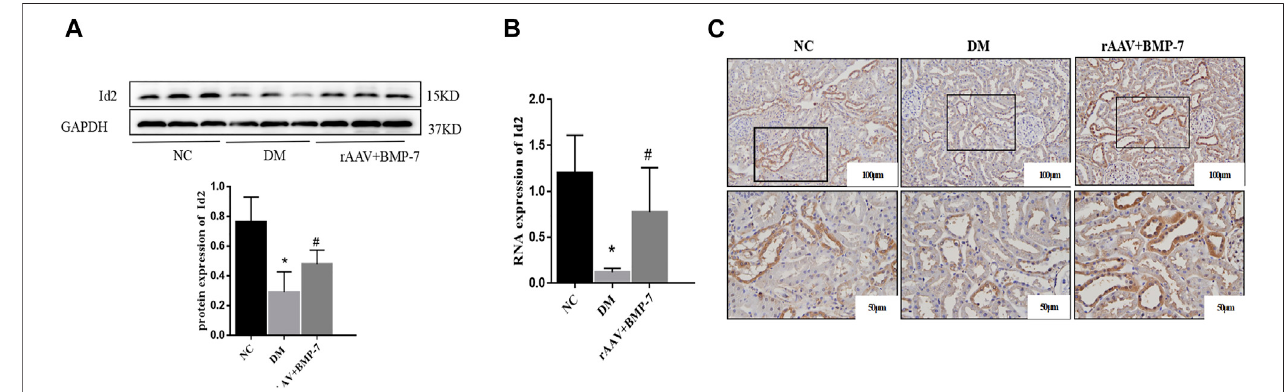
FIGURE 6 | To verify the changes in protein and mRNA levels of Id2 after overexpression of BMP-7 in vivo . (A) Western blot was used to detect Id2 protein expressionlevelsinthenormalcontrolgroup,diabetesmodelgroup,andrAAV+BMP-7group,* p < 0.05vs.NCgroup,# p < 0.05vs.DMgroup. (B) Real-timePCRwas